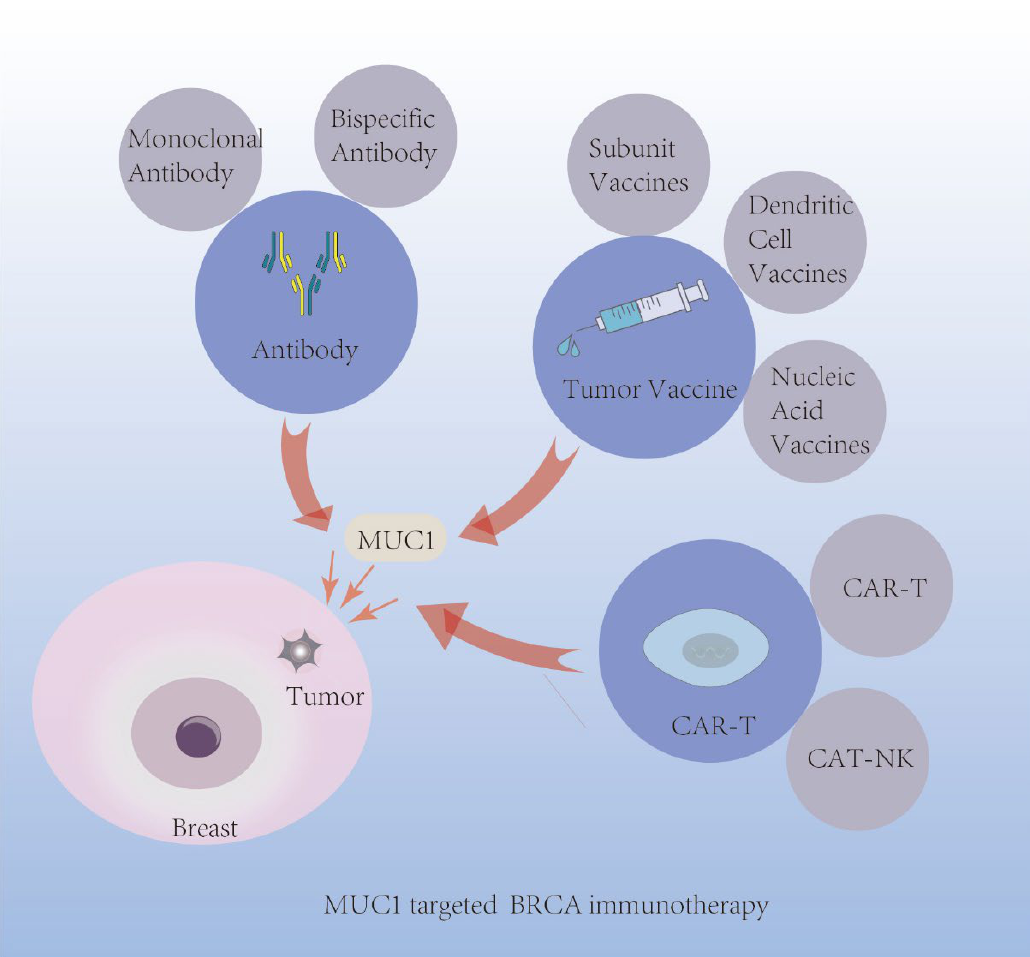
Figure 4. Application of MUC1 mediated immunotherapy in